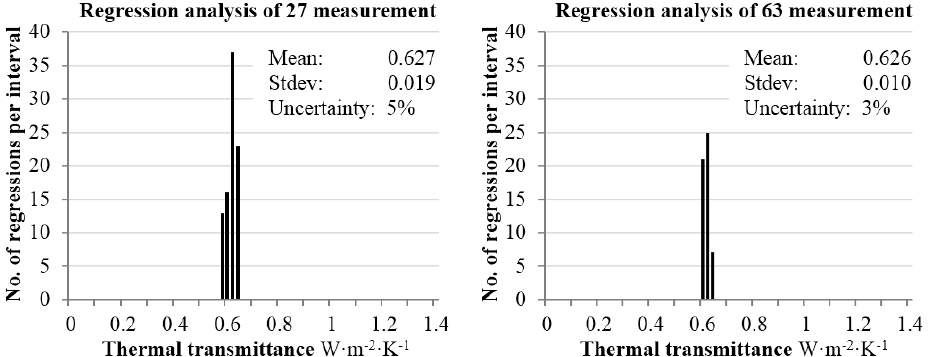
Figure A4. The distribution of the values of the thermal transmittance obtained by regression analysis as described in Section 2.4 in the main article. Each plot represents a different number of thermal images included in the regression analysis.